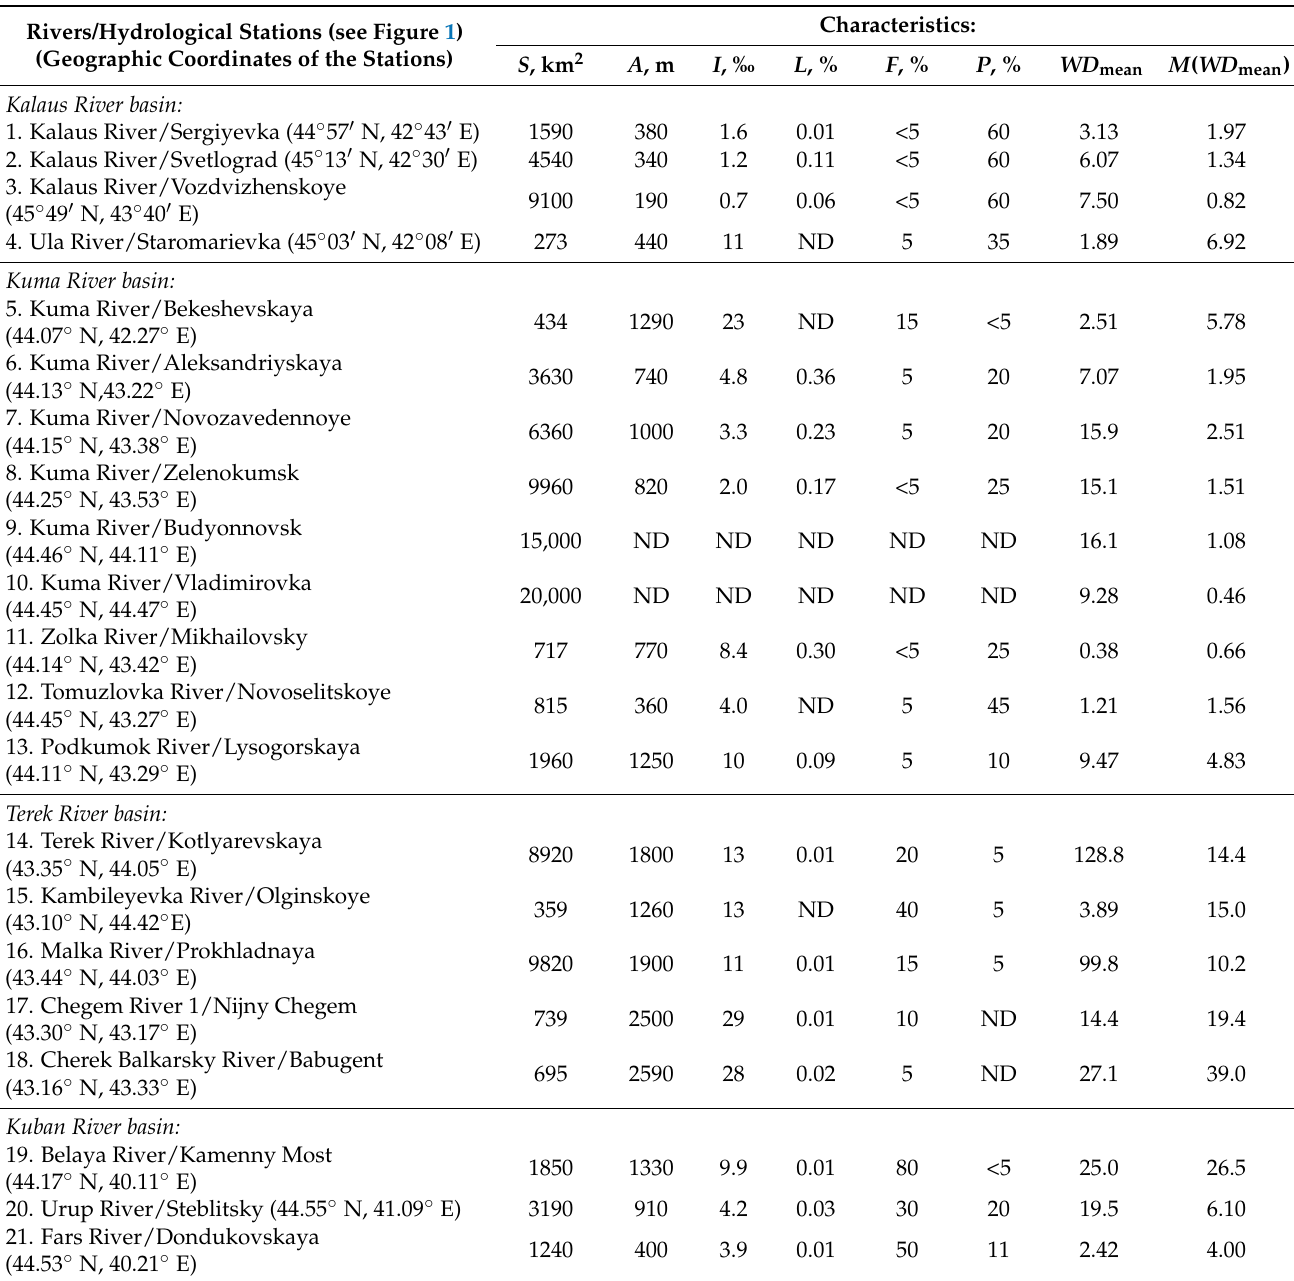
Characteristics: S , km 2